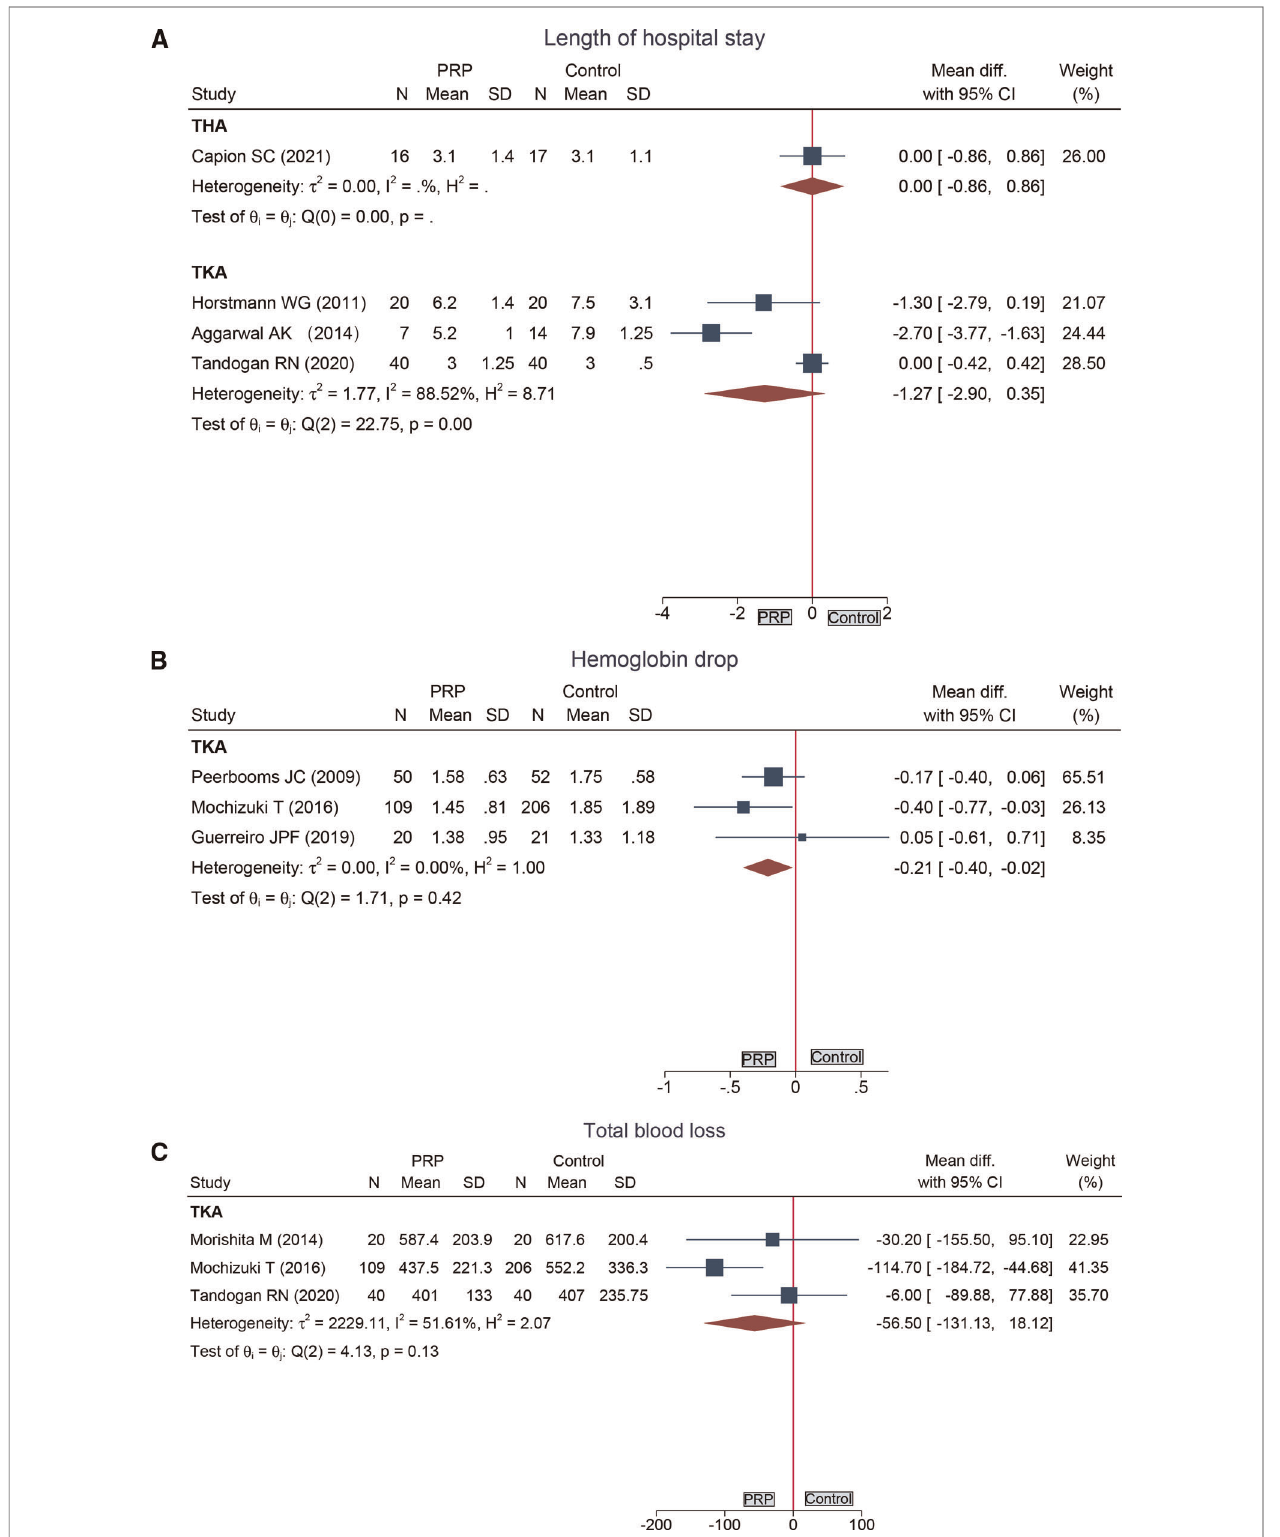
FIGURE 6 | Forest plot presents the pooled results for: ( A ) length of hospital stay; ( B ) hemoglobin drop; ( C ) total blood loss.